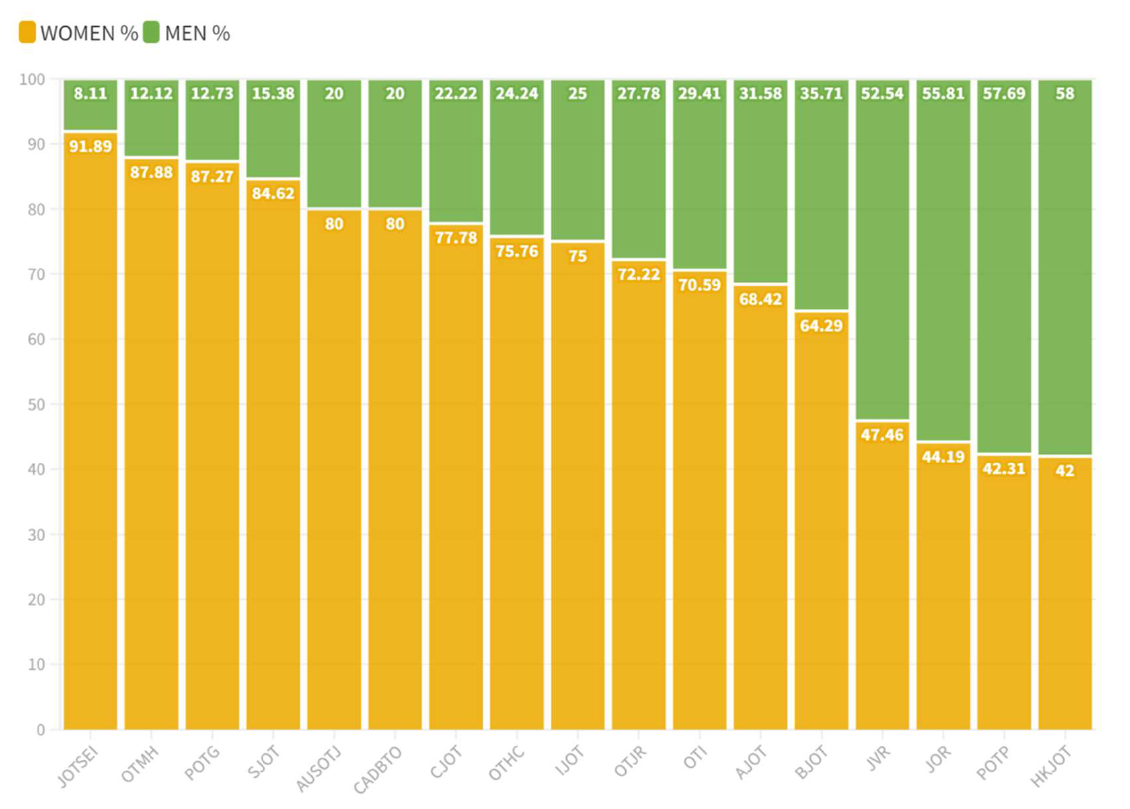
Figure 3. Gender composition of the editorial boards. JOTSEI: Journal of Occupational Therapy, Schools, and Early Intervention; OTMH: Occupational Therapy in Mental Health; POTG: Physical